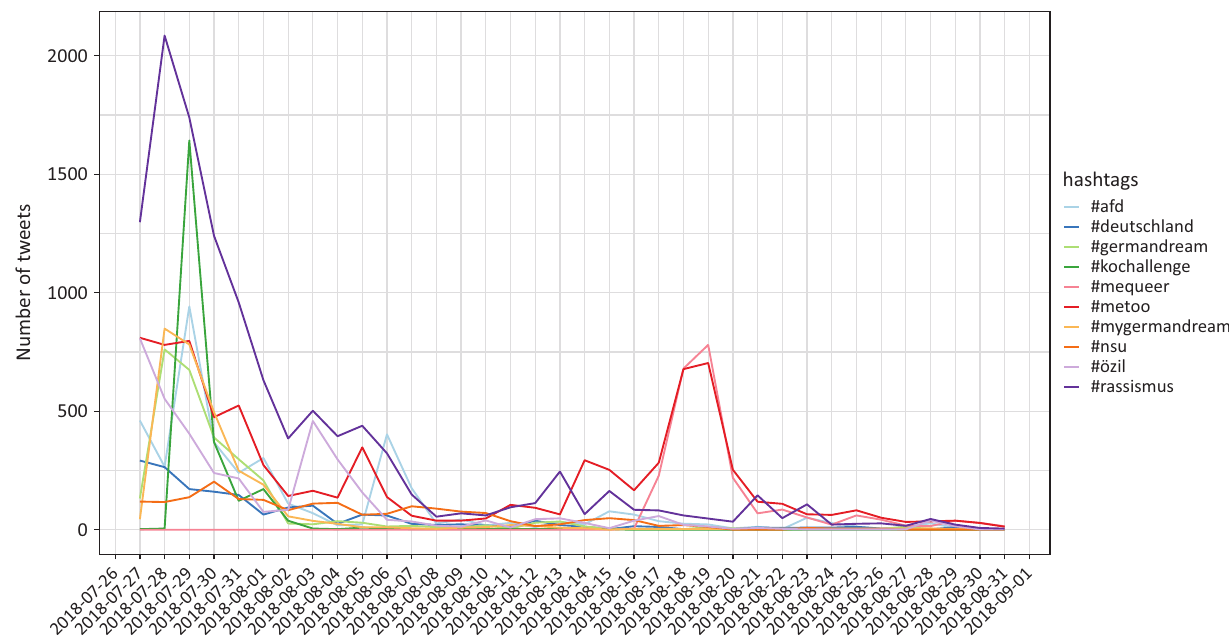
Figure 1. 10 most frequent co-occurring hashtags in the sample over